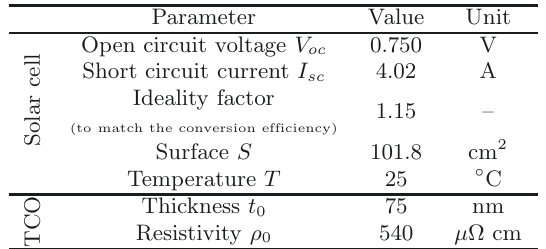
Table 3. Parameters of an ideal efficient solar cell with a top TCO layer.